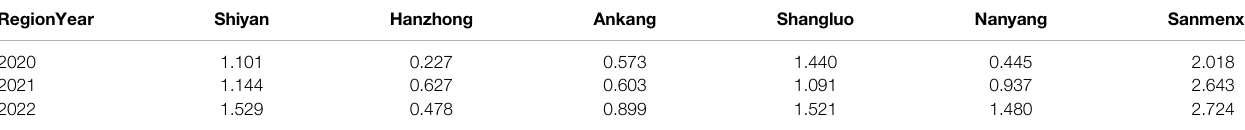
TABLE 4 | Ecological compensation prices of regions in water source areas in 2020 – 2022. Unit: yuan. RegionYear